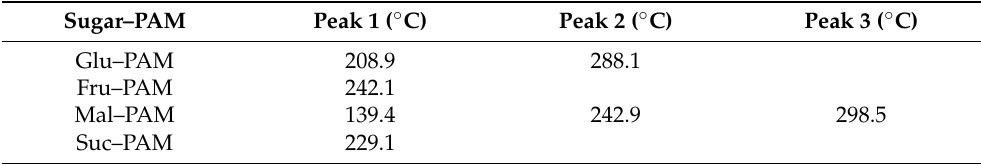
Figure 3. TGA and DTG curves of four sugar – PAM hydrogels ( a ) Glu – PAM, ( b ) Fru – PAM, ( c ) Mal – PAM hydrogel, ( d ) Suc – PAM hydrogel. Table 1. The peak temperature of four sugar – PAM hydrogels in DTG curves.